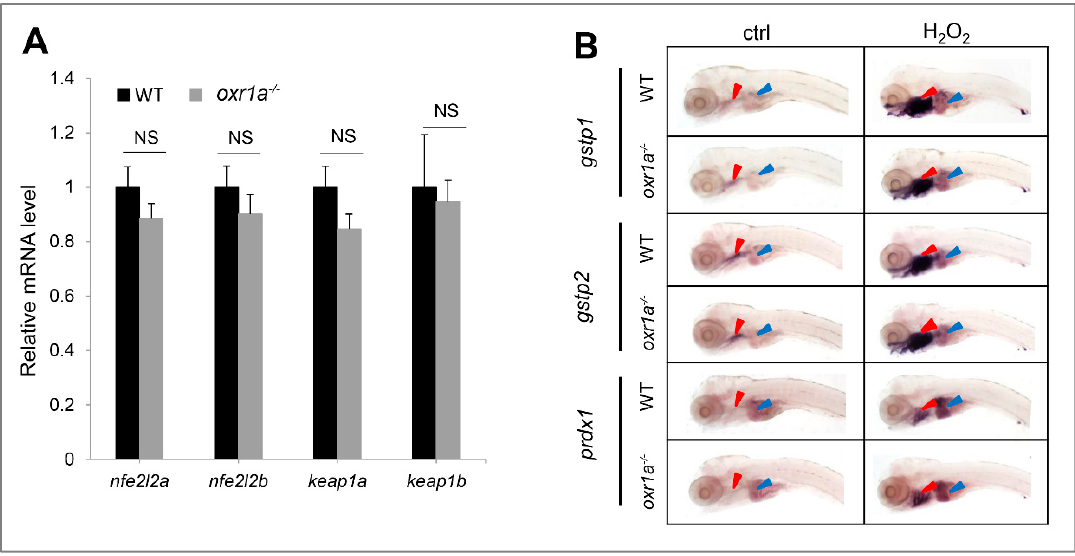
Figure 7. Effect of oxr1a mutation on Keap1/Nrf2 pathway during oxidative stress. ( A ) Oxr1a mutation does not affect the gene expression of major members in the Keap1/Nrf2 pathway. ( B ) Nrf2 target genes gstp1 , gspt2 and prdx1 in response to H 2 O 2 for 3 h were examined by WISH. n = 20, and the positive rate of expression signal is about 90%; Oxr1a mutation does not affect the antioxidant response of Nrf2 target genes. Red and blue arrowheads labeled the gills and liver, respectively. ctrl indicates the larvae were not treated by H 2 O 2 . NS indicates no significant differences ( p > 0.05). Table 1. Summary for the filtering and mapping of reads.